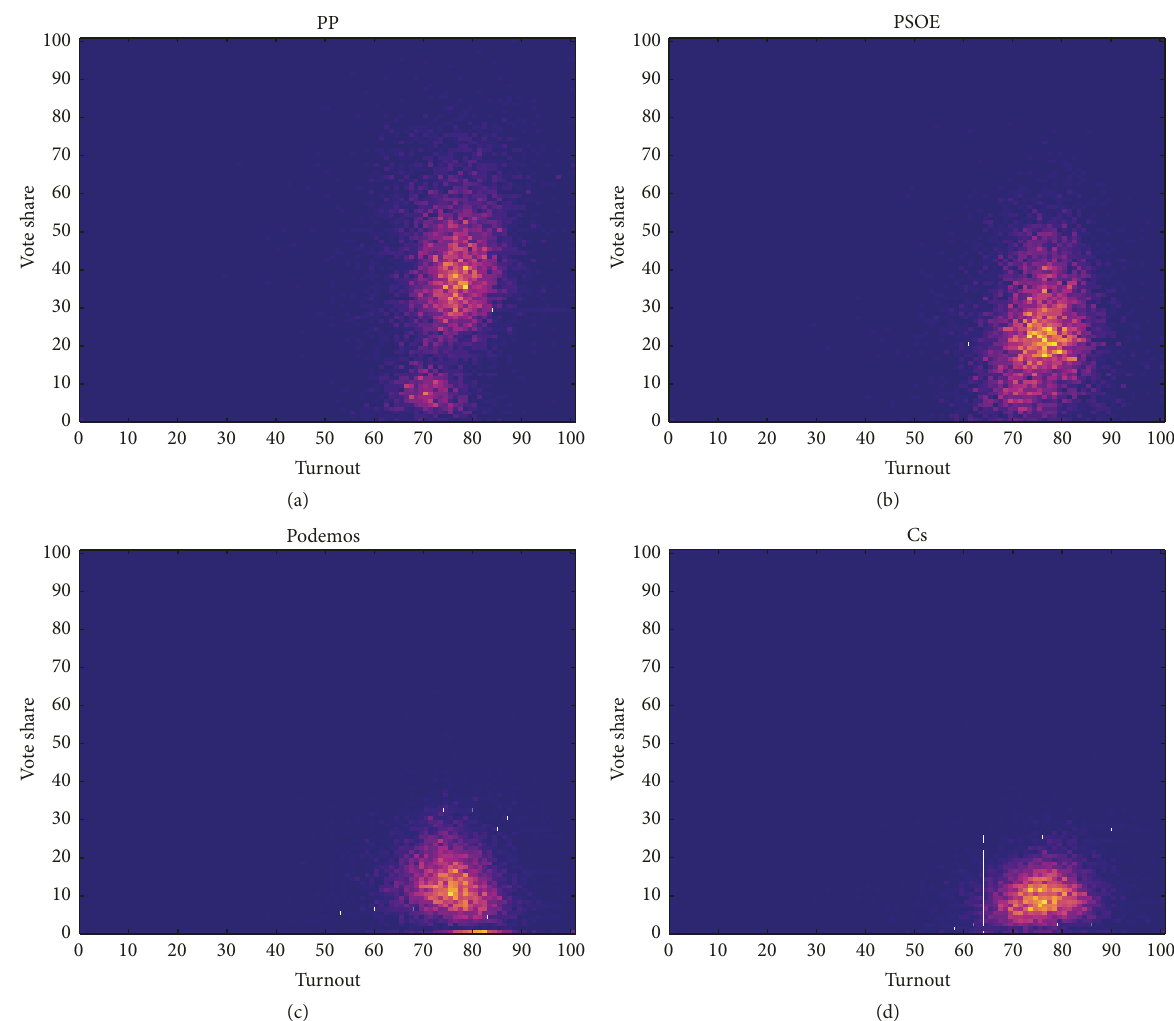
Figure 17: Heat maps plotting the percentage (in color scale) of municipalities where a given political party has received a certain percentage of votes, as a function of the relative participation. These are results associated with December 2015 elections. According to Klimek et al. [5], a smear out of the cluster towards the top-right corner of the heat map is a sign of incremental fraud, whereas extreme fraud would occur for bimodal distributions where a cluster emerges at the top-right corner.